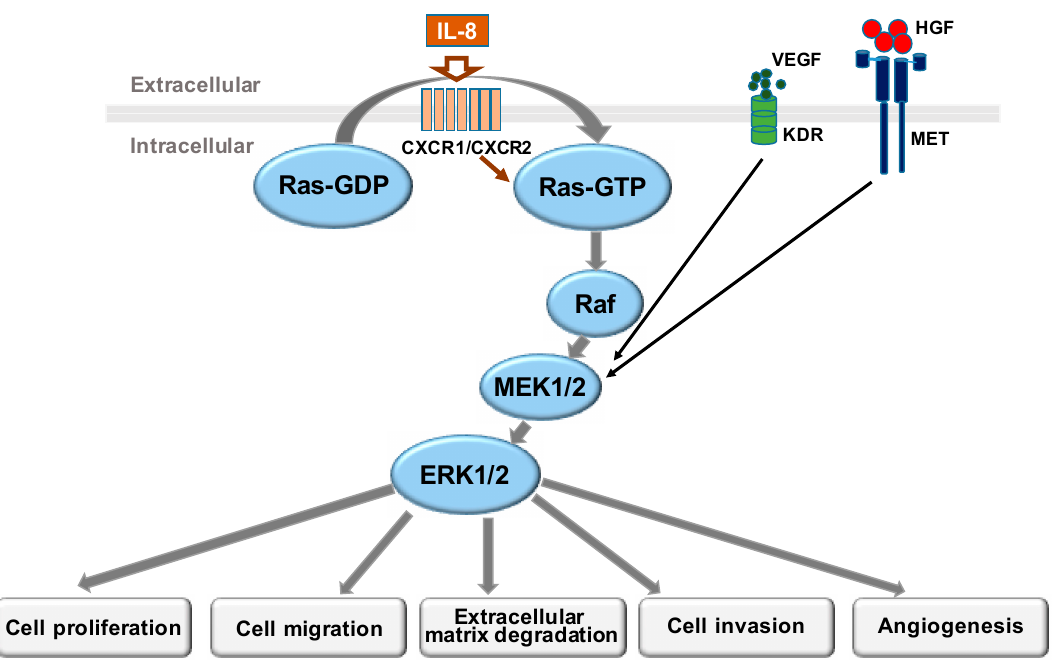
Figure 1. Role of mitogen-activated protein kinase (MAPK)/extracellular signal-regulated kinase (ERK) in epithelial ovarian cancer (EOC). The ERK/MAPK signaling pathway regulates tumorigenesis in EOC through cell proliferation, cell migration, extracellular matrix degradation, cell invasion, and angiogenesis. KDR, kinase insert domain receptor; MET, mesenchymal epithelial transition factor; CXCR, C-X-C motif chemokine receptor.